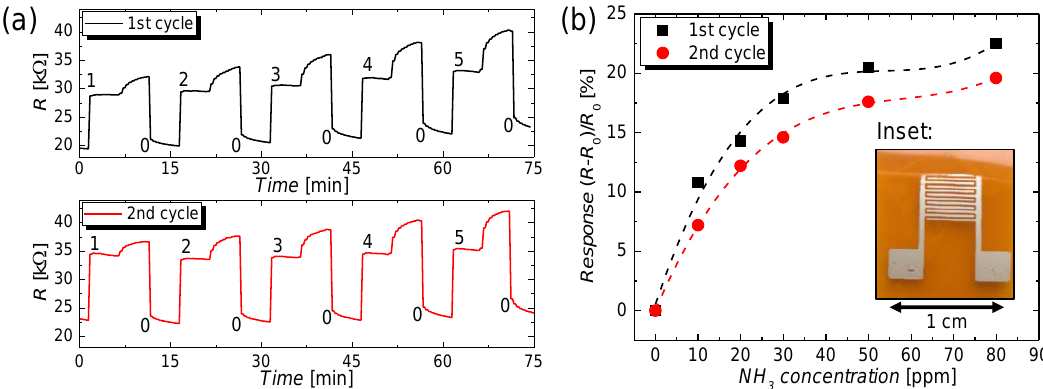
Figure 5. ( a ) Increase in resistance over time of a CNT-based sensor with a screen printed interdigitated electrode (IDE) structure that is shown in the inset in ( b ). The sensor is subjected to NH 3 gas for two cycles and for increasing concentrations of 0, 10, 20, 30, 50, and 80 ppm. The moments at which the different concentrations are input are labelled consecutively in the graph from 0–5. ( b ) Saturated